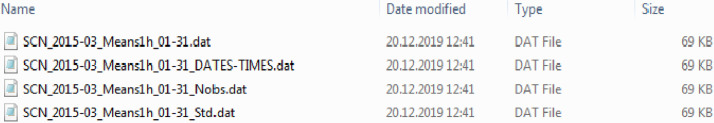
Organization of the processed data files: 1-h means for averages over all visible satellites.